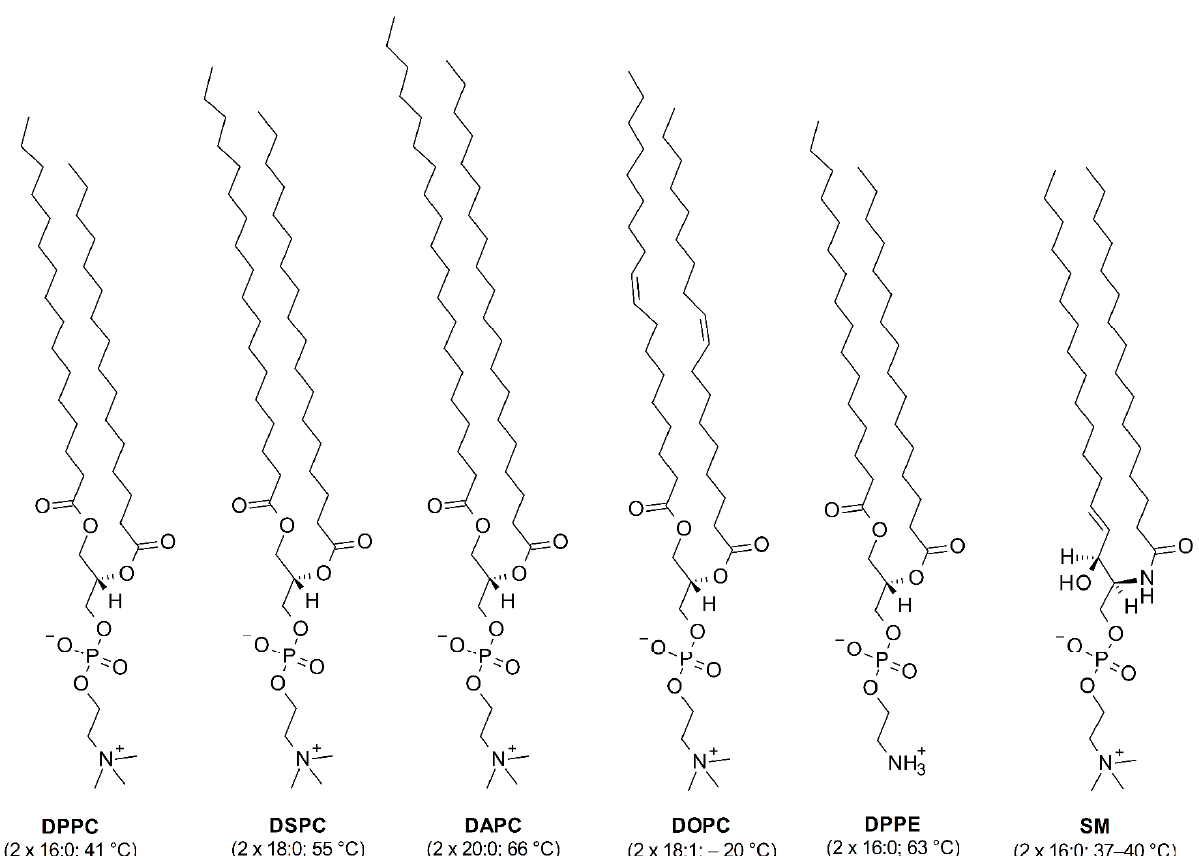
Figure 1. Chemical structures of the studied phospholipids together with acyl chain lengths. Chain melting temperatures of the hydrocarbon chains are given in parentheses. DPPC- 1,2-dipalmitoyl-sn-glycero-3-phosphocholine; DSPC- 1,2- distearoyl-sn-glycero-3-phosphocholine; DAPC -1,2-diarachidoyl-sn-glycero-3-phosphocholine; DOPC- 1,2-dioleoyl-sn- glycero-3-phosphocholine; DPPE- 1,2-dipalmitoyl-sn-glycero-3-phosphoethanolamine; SM- N-(hexadecanoyl)-sphing-4- enine-1-phosphocholine